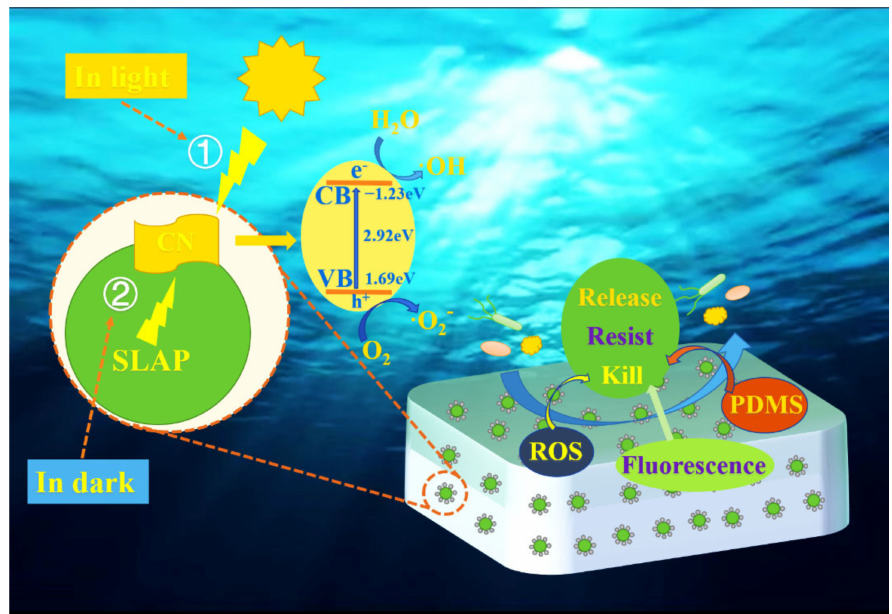
Figure 9. Schematic diagram of the attachment mechanism of anti-marine